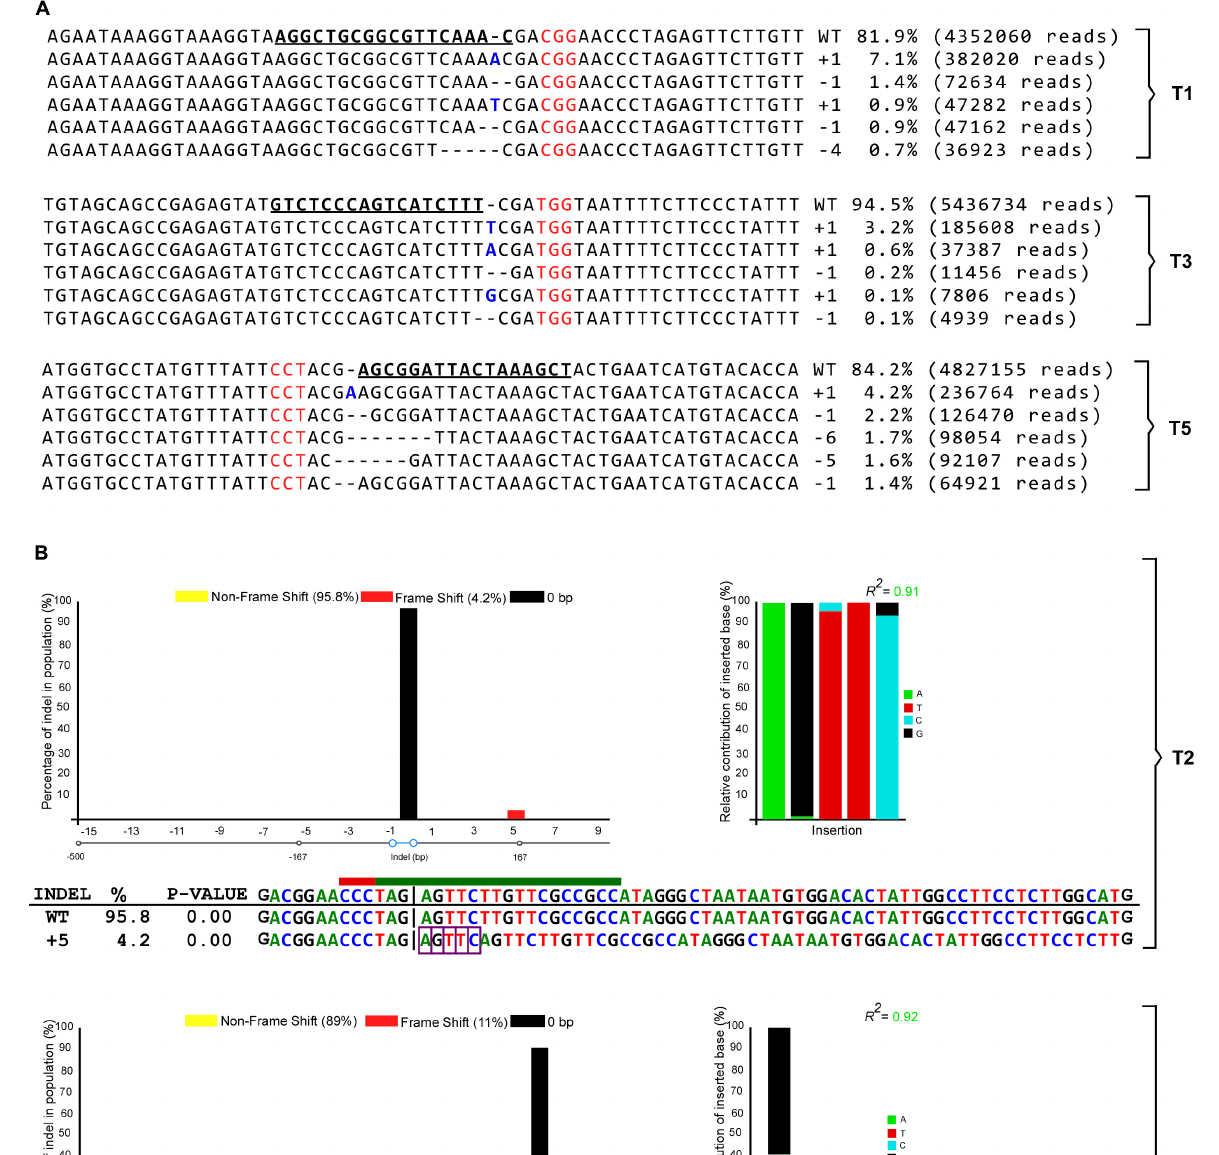
FIGURE 7 | Mutation patterns observed by targeted deep and Sanger sequencing for the corresponding target sites at GmCPR5 loci are shown. (A) Distribution of the five most frequent alleles along with their mutation pattern, contribution percentage, and read count observed with the Cas-Analyzer around targeted sites in GmCPR5 for T1, T3, and T5. Wild-type (WT) nuclease target sequences were in bold and underlined. PAM sites are denoted by the red font. Insertions and deletions are shown in bold font (blue) and horizontal dashed lines, respectively. (B) The result of editing efficiency and mutation patterns analyzed with DECODR software for T2 and T4. The top panels display the graphs for the InDel distribution rate. The bottom panel shows the list of deconvoluted InDel-containing sequences as alignments along with InDel types and percentages (%). Insertion (highlighted with purple rectangles) and deletion (marked with horizontal dashed lines) of mutations are shown in alignments. A 20 bp target and 3 bp PAM site are depicted with green and red lines, respectively.